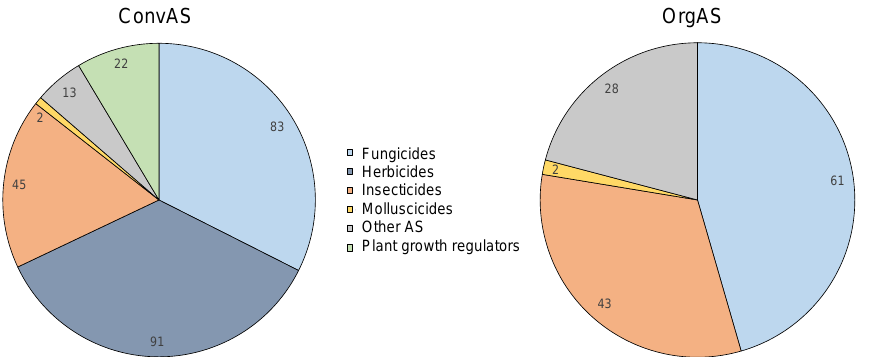
Figure 1. Assignment of active substances (AS) approved in conventional (ConvAS, n = 256) or organic agriculture (OrgAS, n = 134) to pesticide categories. The numbers in the sectors indicate the number of AS.